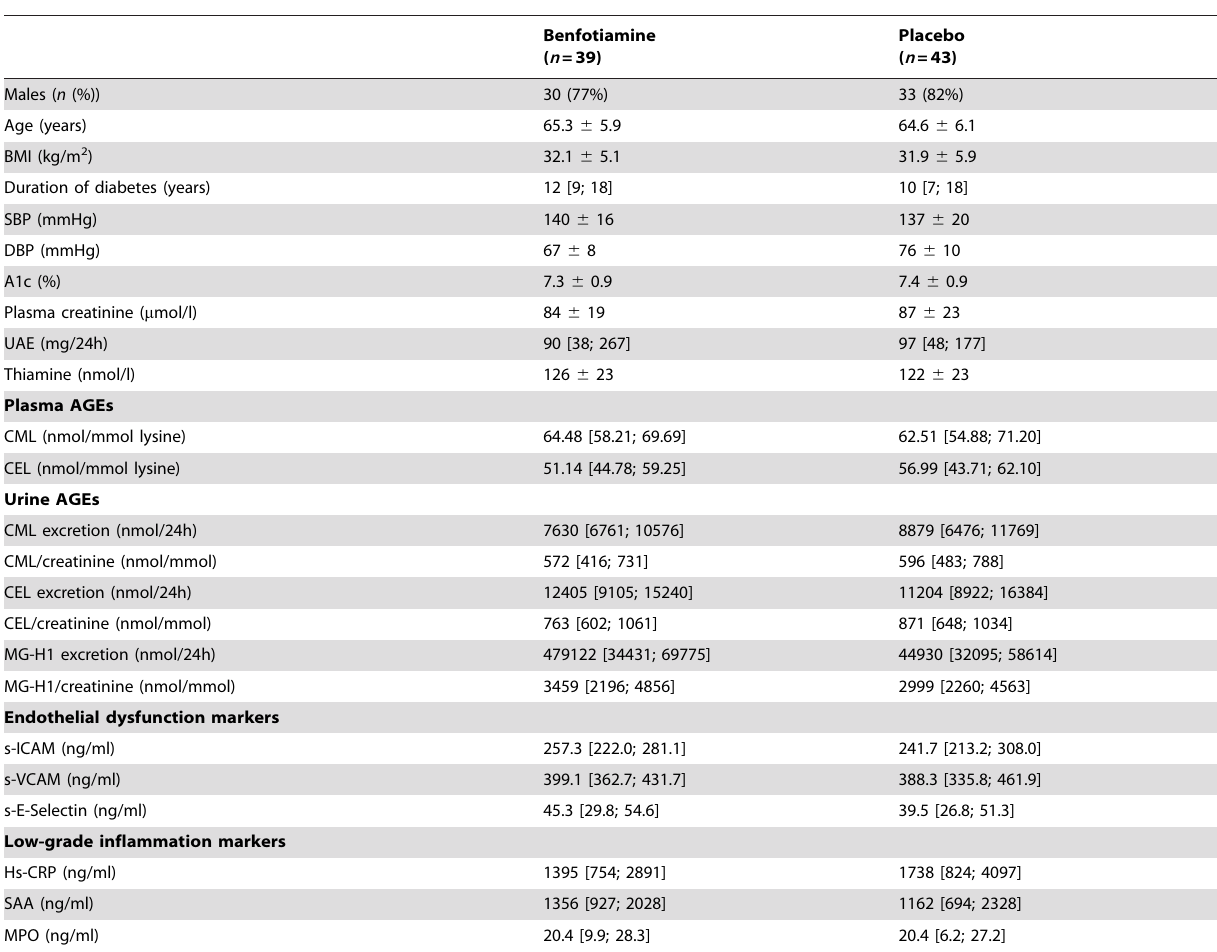
Table 1. Baseline characteristics of study